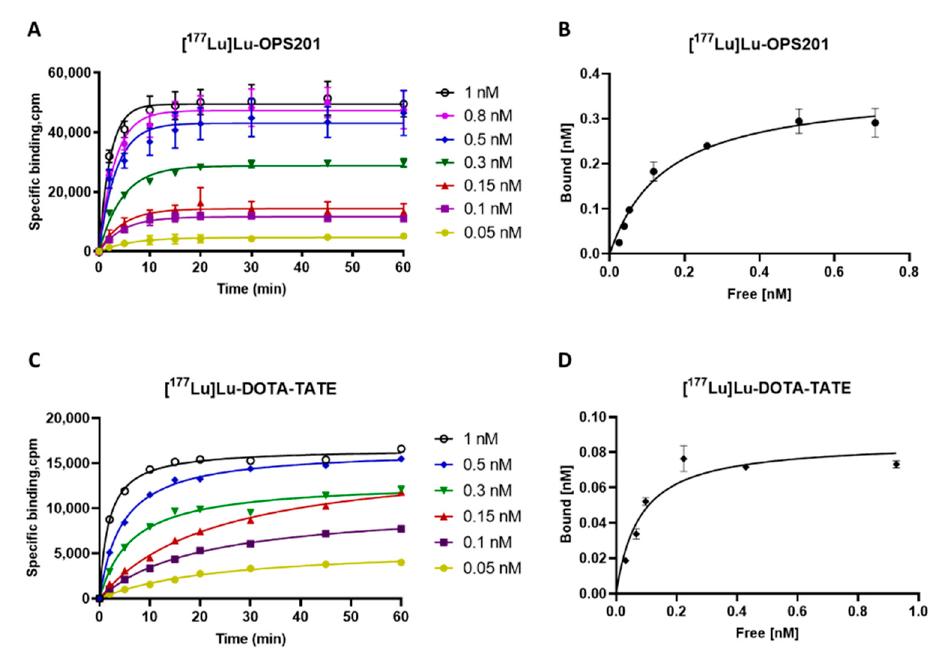
Figure 1. Association versus time plots for specific binding of [ 177 Lu]Lu-OPS201 ( A ) and [ 177 Lu]Lu-DOTA-TATE ( C ) to HEK-SST 2 cell membranes (10 µ g/well). Membranes were incubated with the indicated concentrations of each radioligand for up to 60 min. Data were fitted using the one-phase exponential association equation. Saturation binding profile for [ 177 Lu]Lu-OPS201 ( B ) and [ 177 Lu]Lu-DOTA-TATE ( D ). Presented binding values refer to the average of the 20–60 min “equilibrium data” for each radioligand concentration.